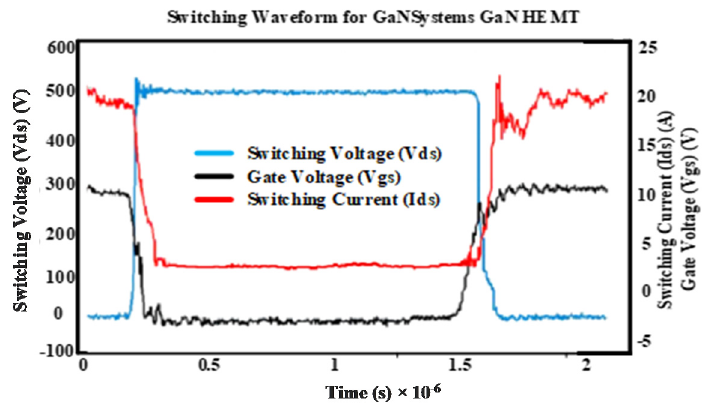
Figure 13. Switching waveforms for GaN Systems GaN HEMT.